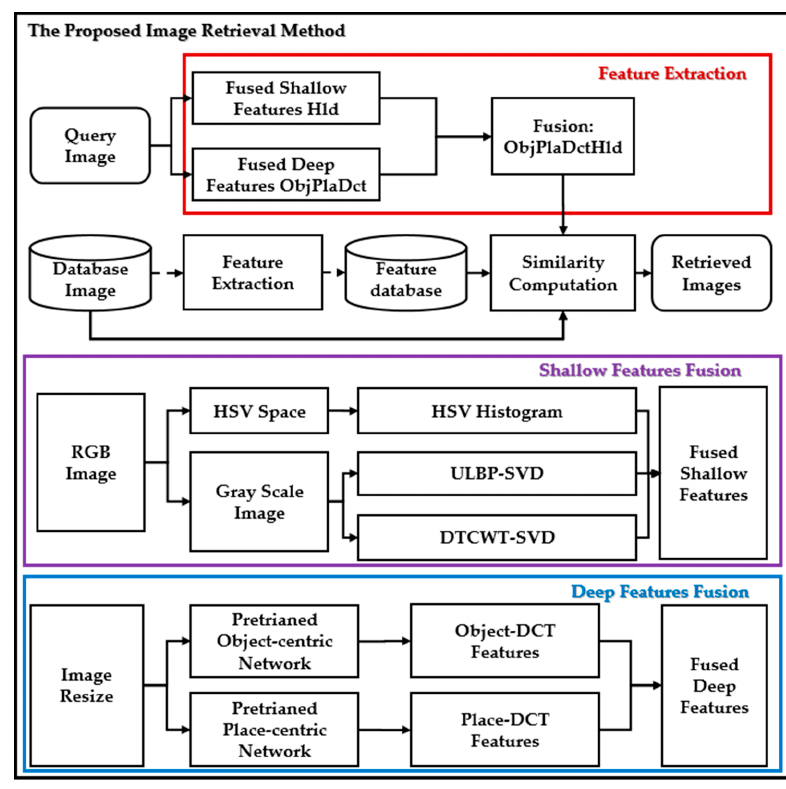
Figure 4. Diagram of proposed image retrieval method.